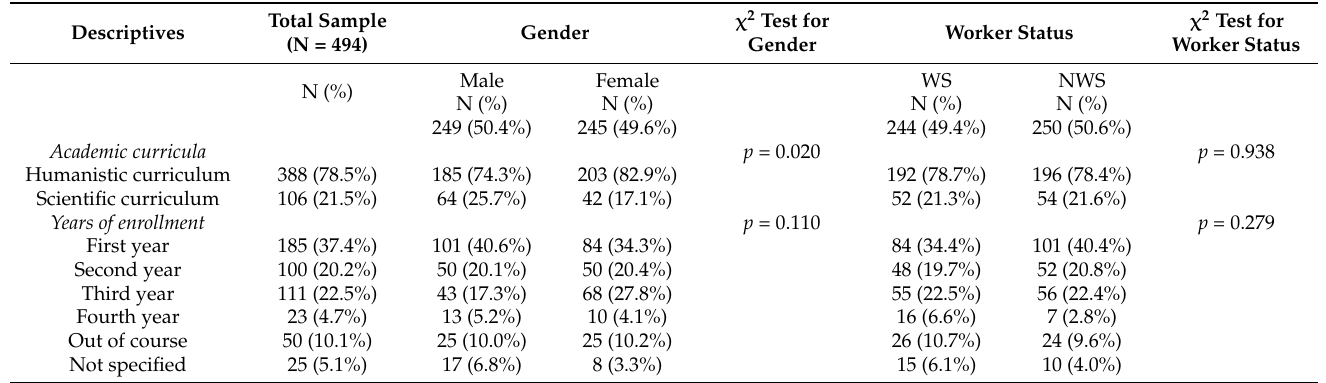
Table 3. Descriptive statistics (frequencies and percentages) of the total sample and split by